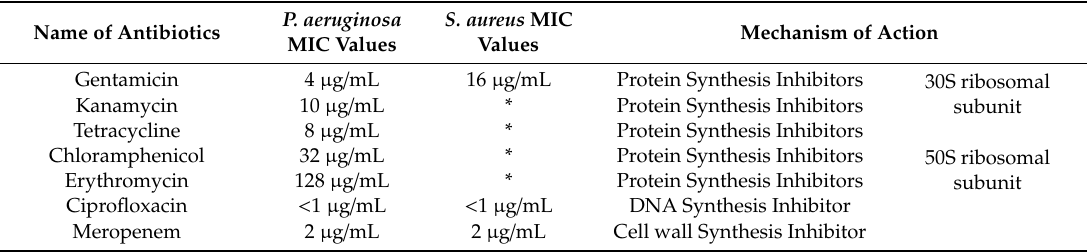
Table 2. List of the antibiotics, MIC values of P. aeruginosa and S. aureus planktonic cells and their mechanism of